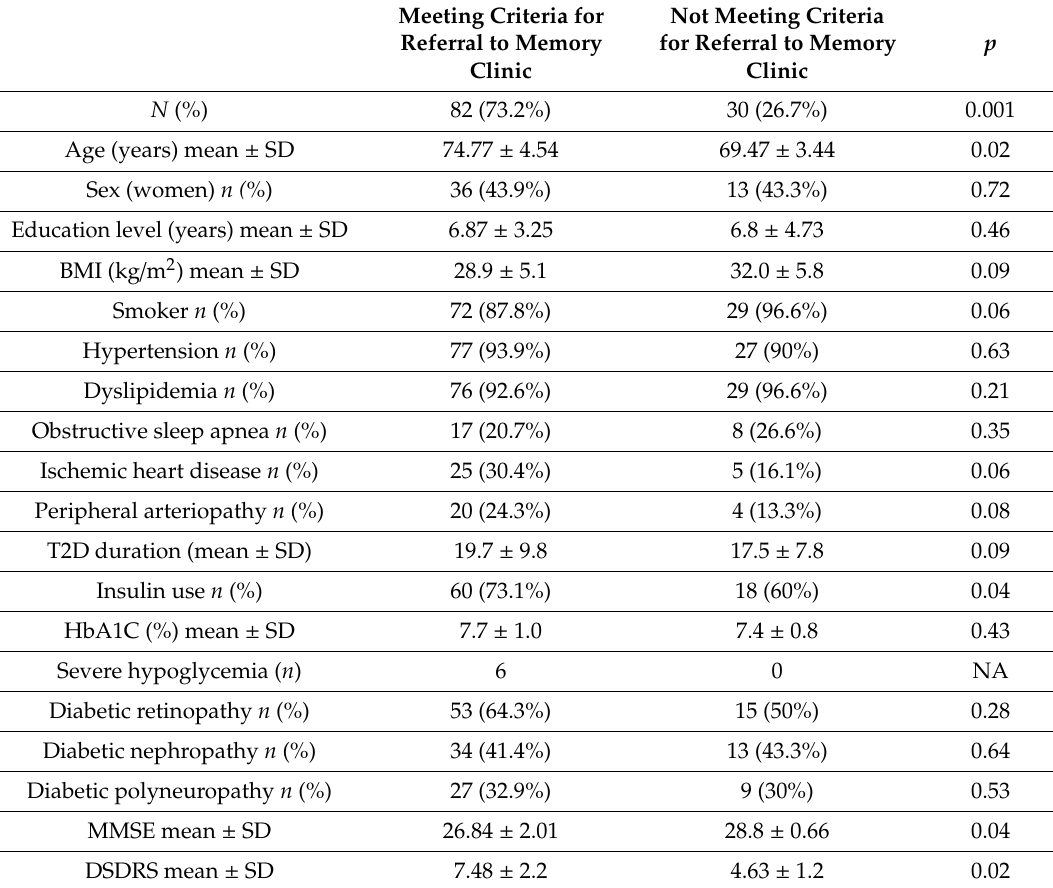
Table 1. Baseline characteristics of the patients included in the